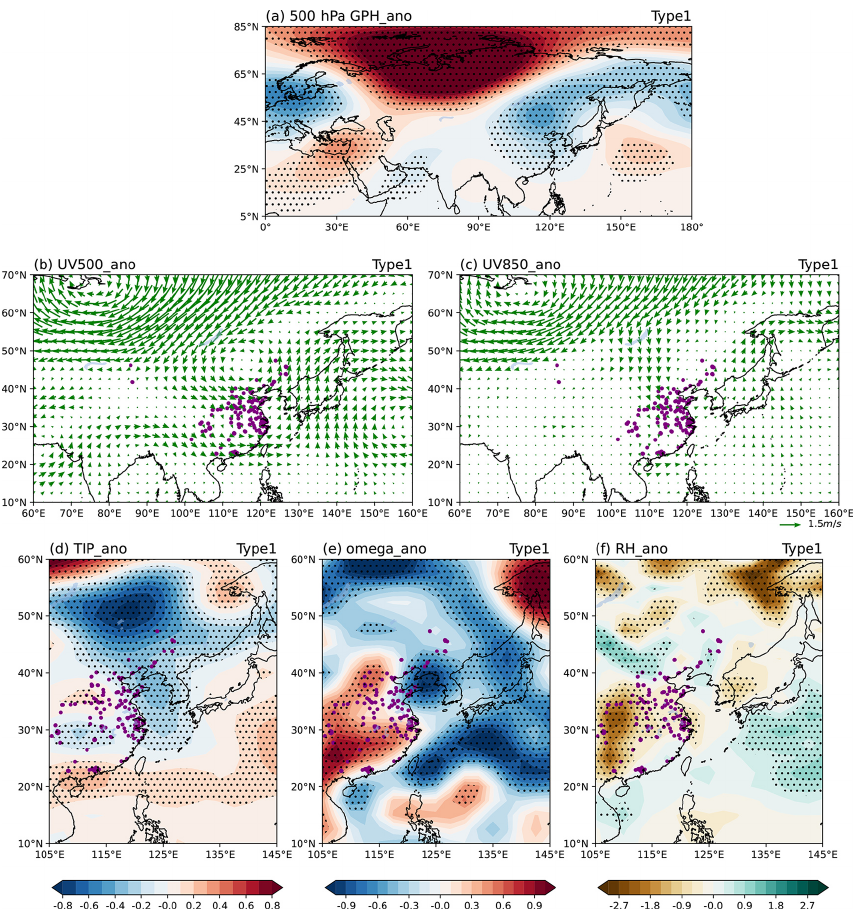
Figure 4. Composite anomalies of (a) GPH at 500hPa (unit: gpm), horizontal wind (unit: ms − 1 ) at (b) 500hPa and (c) 850hPa, (d) TIP (unit: K), (e) omega (unit: 10 − 2 Pas − 1 ), and (f) RH (unit: %) for circulation Type1. Dotted areas are statistically significant at the 95% confidence level. The purple dots represent the stations dominated by circulation